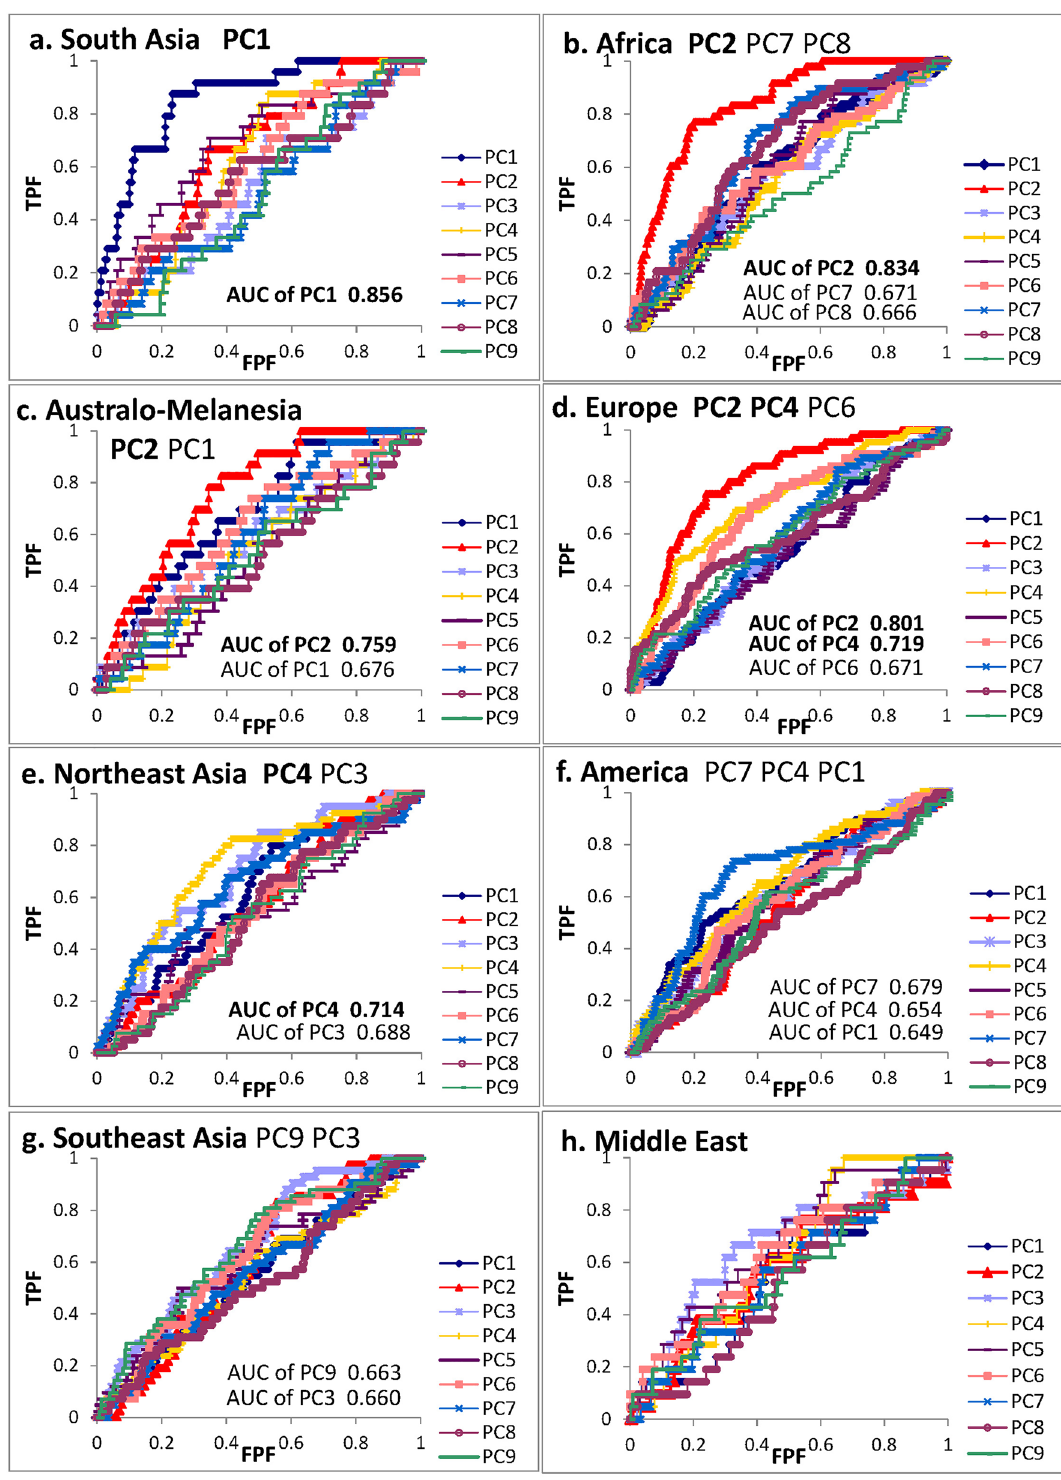
Figure 2. ROC curves applied to nine principal component scores based on vertex data sets of 342 male homologous cranial models. AUC: area under the curve with significance at 0.01% level to distinguish each geographical assemblage from other pooled assemblage. TPF true-positive fraction (effective discrimination), FPF false-positive fraction (non-effective